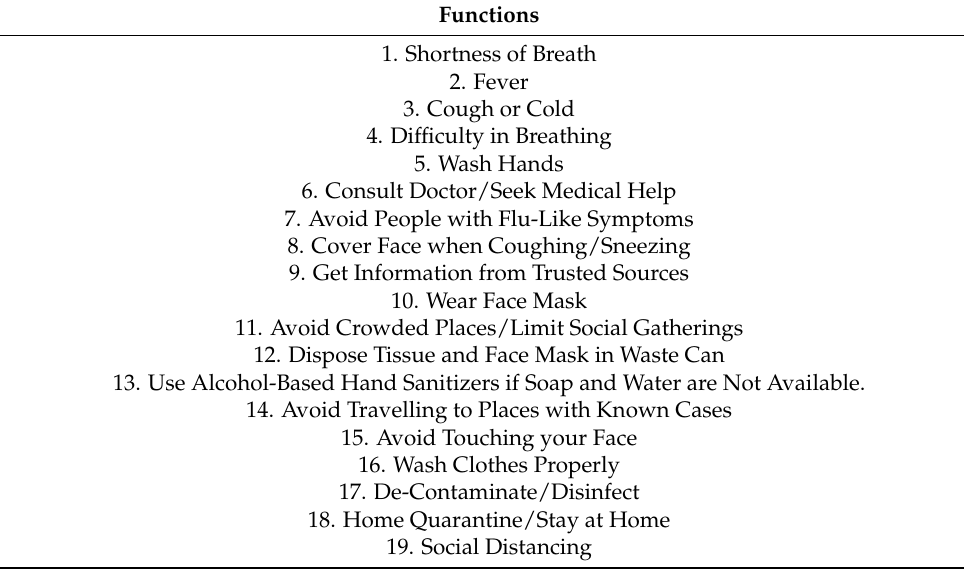
Table 2. Function names of icons related to COVID-19 preventive